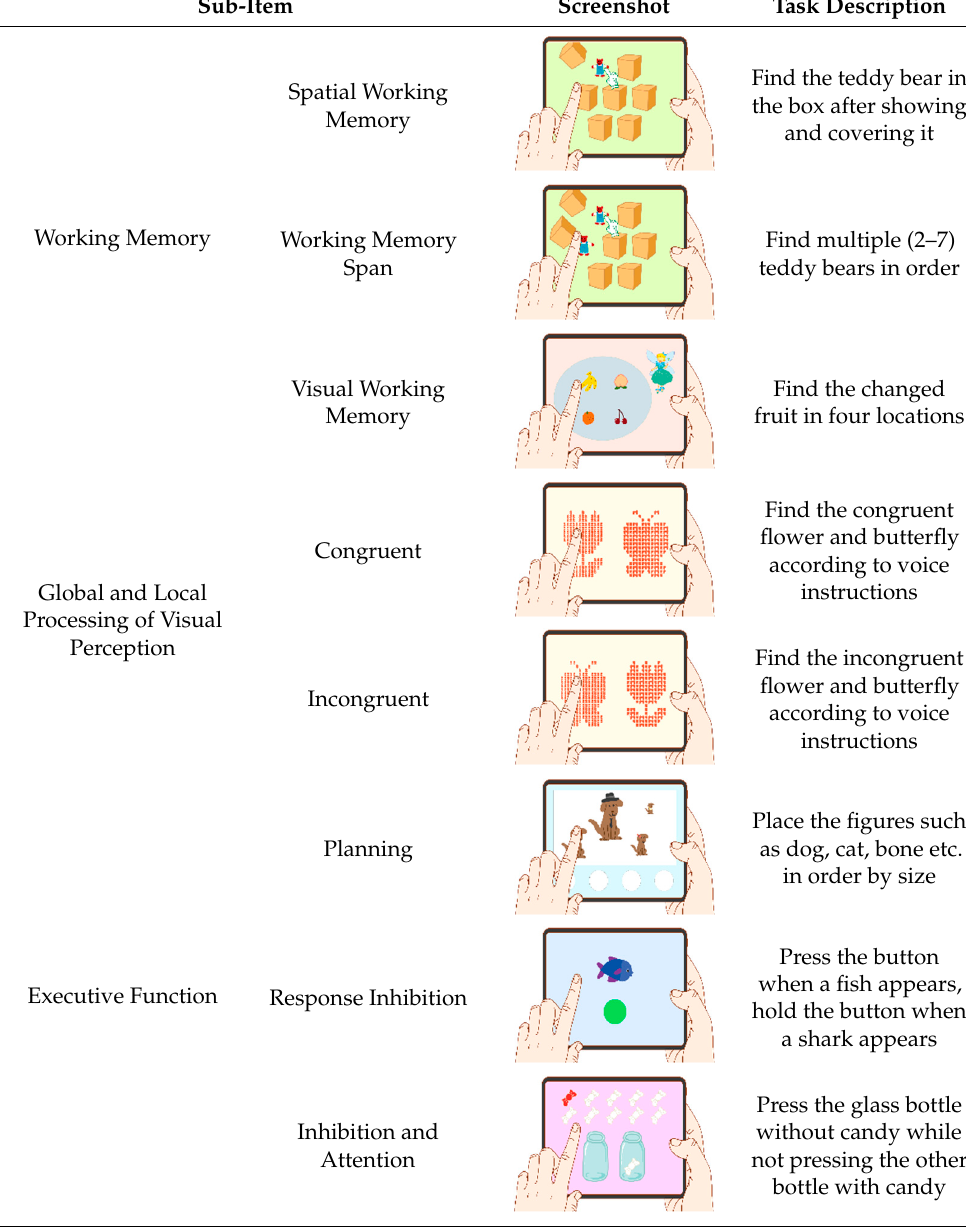
Figure 2. Digital cognitive function testing using a tablet-based app, patent application 10-2020- 0147889 (Republic of Korea, 2022). 2.5. Social Skills Test A tablet-based app was used to assess the social skills of children with developmental disabilities (Figure 3) [24]. The assessment consisted of eight items as follows: imitation, joint attention, pre-symbolic knowledge, symbolic behaviors, understanding rules, emo- tion perception, and perspective-taking. The maximum score of each sub-item was 10 for a total score of 80. The time taken for the assessment was approximately 20 min, with variations according to the level of social skills across the participants. The details of the sub-items are listed in Table 6. A ROC analysis was performed to determine the cutoff score for the upper and lower ranges of social skills. For a total score of ≥ 64.5, the partici- pants were classified into a higher-level CS-VR exercise program. For a total score of <64.5, the participants were classified into the lower-level CS-VR exercise program.